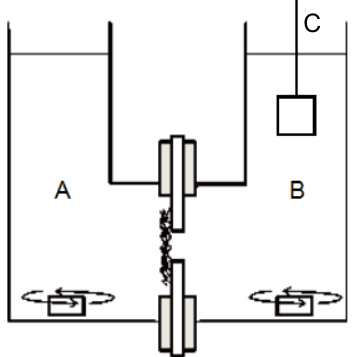
Figure 1. U-shaped glass cell for measuring ion permeation: ( A ) Source phase (50 mL); ( B ) Receiving phase (50 mL); ( C ) Conductivity cell. A conductivity cell was immersed in the receiving phase to monitor the concentration of salt